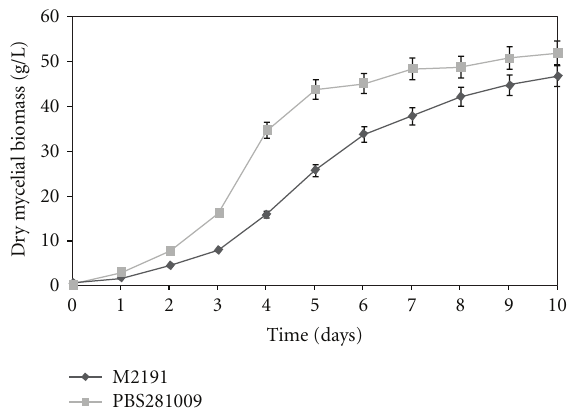
Figure 1: Mycelial growth by submerged culture of Pleurotus ostreatus M2191 and PBS281009 in a New Brunswick BioFlo 310 bioreactor.